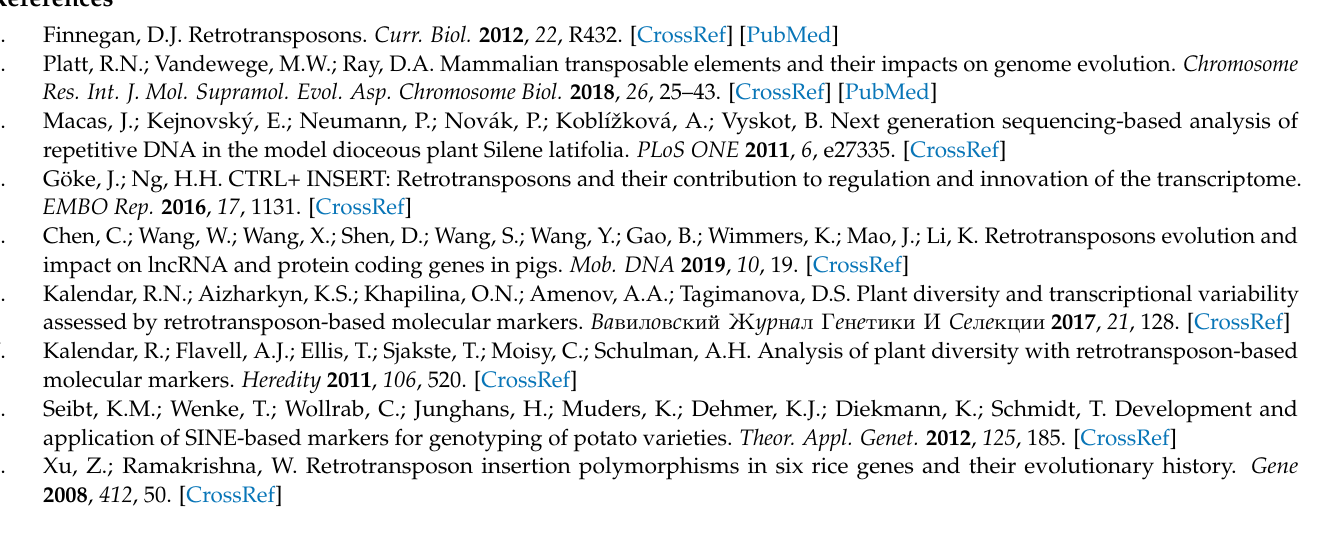
Table S6: The p -value result of statistical analysis for the RIPs with the reproductive characteristics of Large White